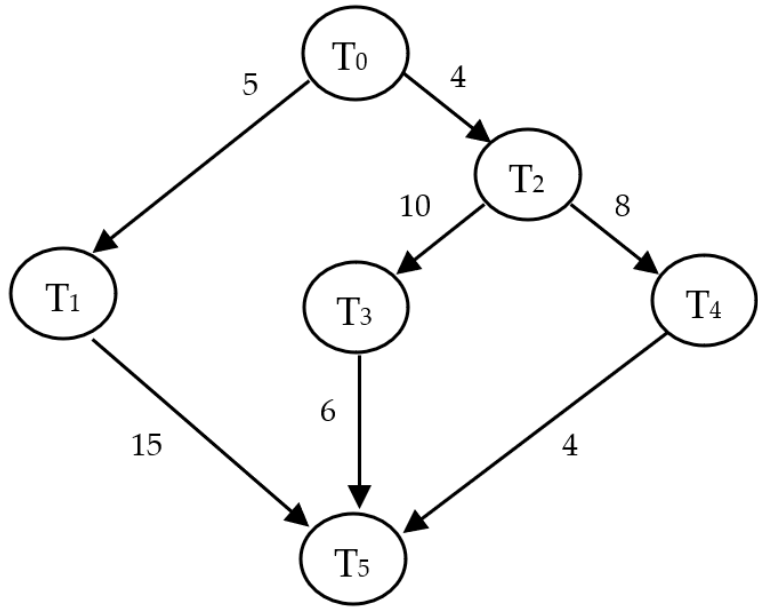
Figure 1. Sample task graph.